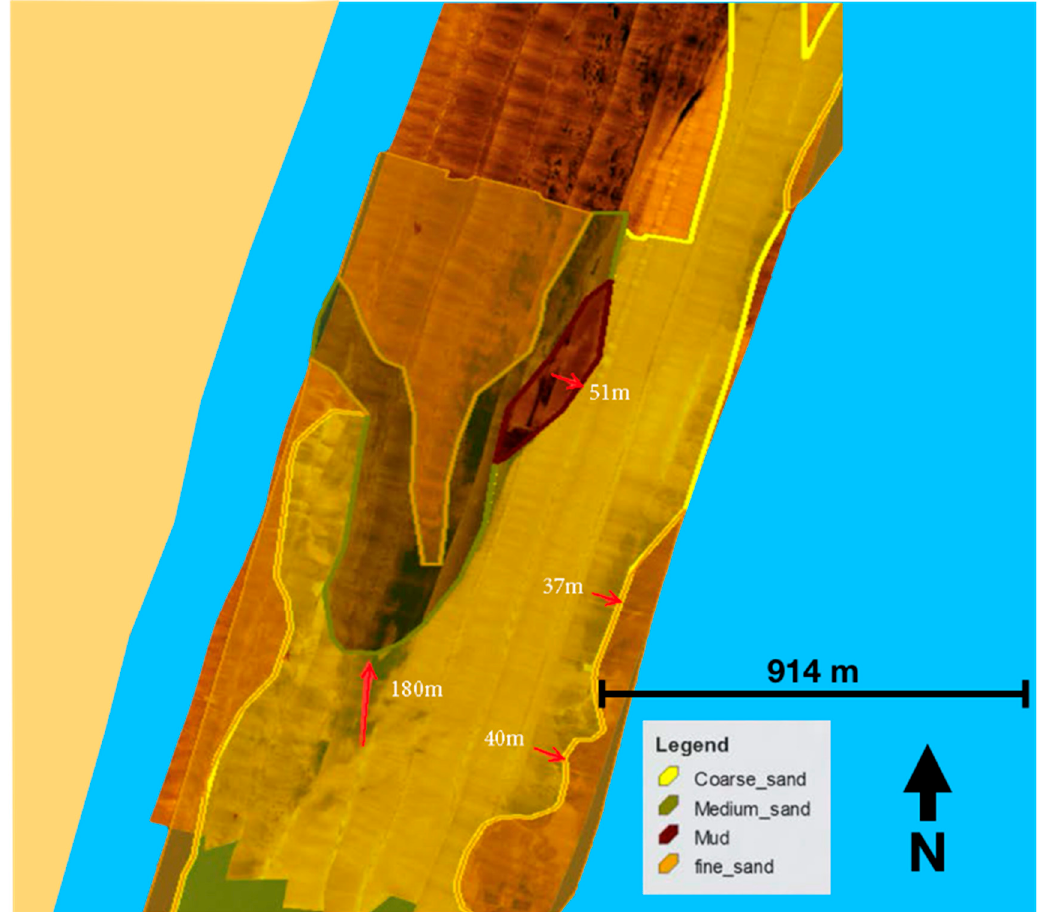
Figure 17. Temporal changes in sediment class boundaries, Assateague Island National Seashore, Maryland. The profile in the bottom is the side-scan sonar mosaics collected during May 2015. Shaded polygons on the top represent sediment classes inferred from the side-scan sonar mosaics collected during October 2015. Please note the northward shift (180 m) in the boundary of mud-coarse sand sediment class and Southeastward shift (37–40m) in the boundary of fine–coarse sand sediment class.